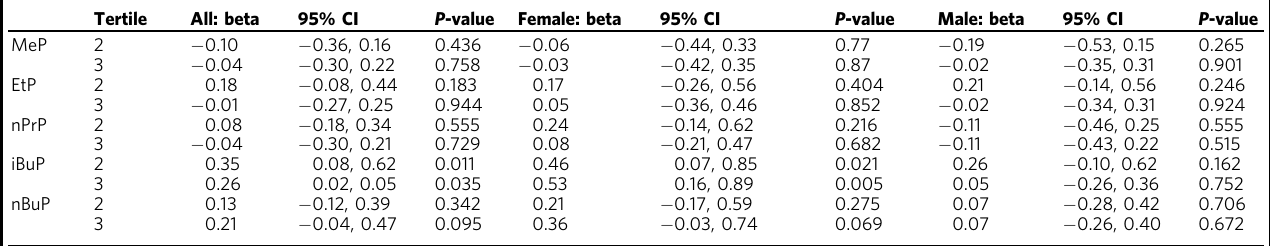
Table 3 Longitudinal effect of prenatal paraben exposure on weight development in childhood (1 – 8 years).